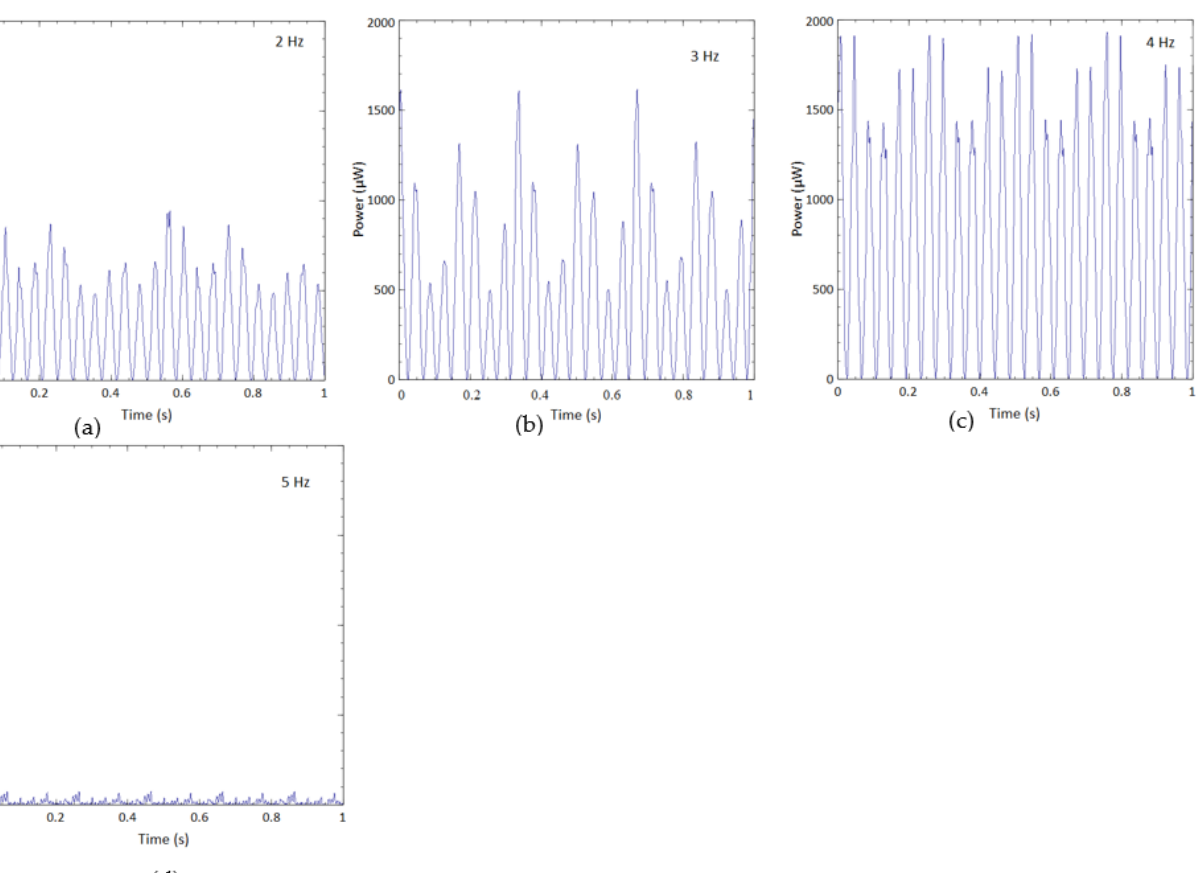
Figure 10. Output power generated by BBBH at ( a ) 2 Hz, ( b ) 3 Hz, ( c ) 4 Hz, and ( d ) 5 Hz under 1 g Figure 10. OutputpowergeneratedbyBBBHat( a )2Hz,( b )3Hz,( c )4Hz,and( d acceleration.